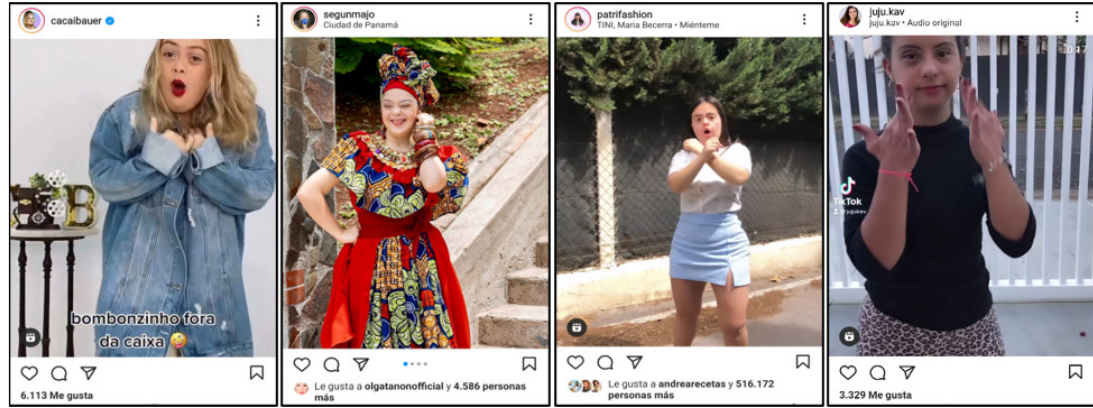
Figure 3. Content creators